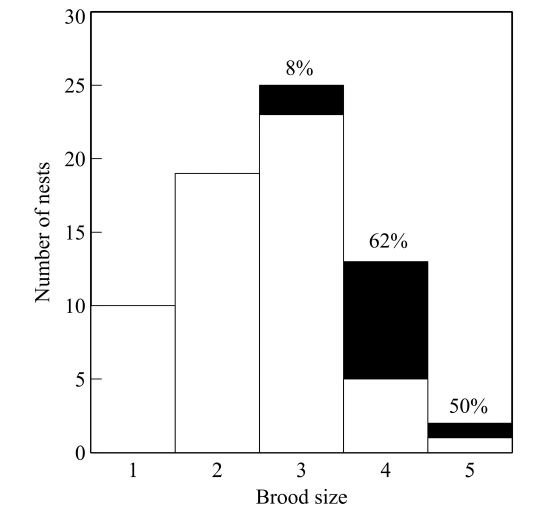
Fig. 4 . Brood size of Turquoise-fronted Parrot ( Amazona aestiva ) as the number of hatched nestlings per nest. Black bars represent the number of nests affected by brood reduction. We observed a positive association between clutch size and brood